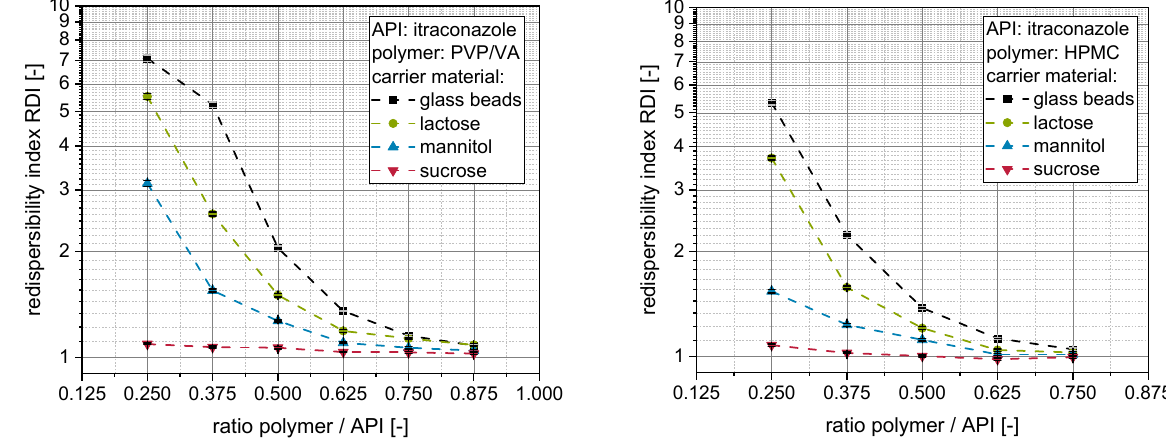
Figure 2. Redispersibility of nanoparticles from granules ( n = 3) produced with glass beads, lactose, mannitol or sucrose as carrier materials as a function of the polymer to API (itraconazole) ratio in the sprayed nanosuspensions and in the product granules. PVP/VA ( left ) or HPMC ( right ) was used as a steric stabilizer in the nanosuspensions and as an additional hydrophilic polymer in the granules. Distinct dependencies of the redispersibility of the nanoparticles on the applied car- rier material can be observed for both nanosuspensions. In accordance with previous solution rate (1.62 mg · cm − 2 · min − 1 ), followed by mannitol (0.64 mg · cm − 2 · min − 1 ) and lactose (0.29 mg · cm − 2 · min − 1 ) [20]. In the present study, it can be additionally